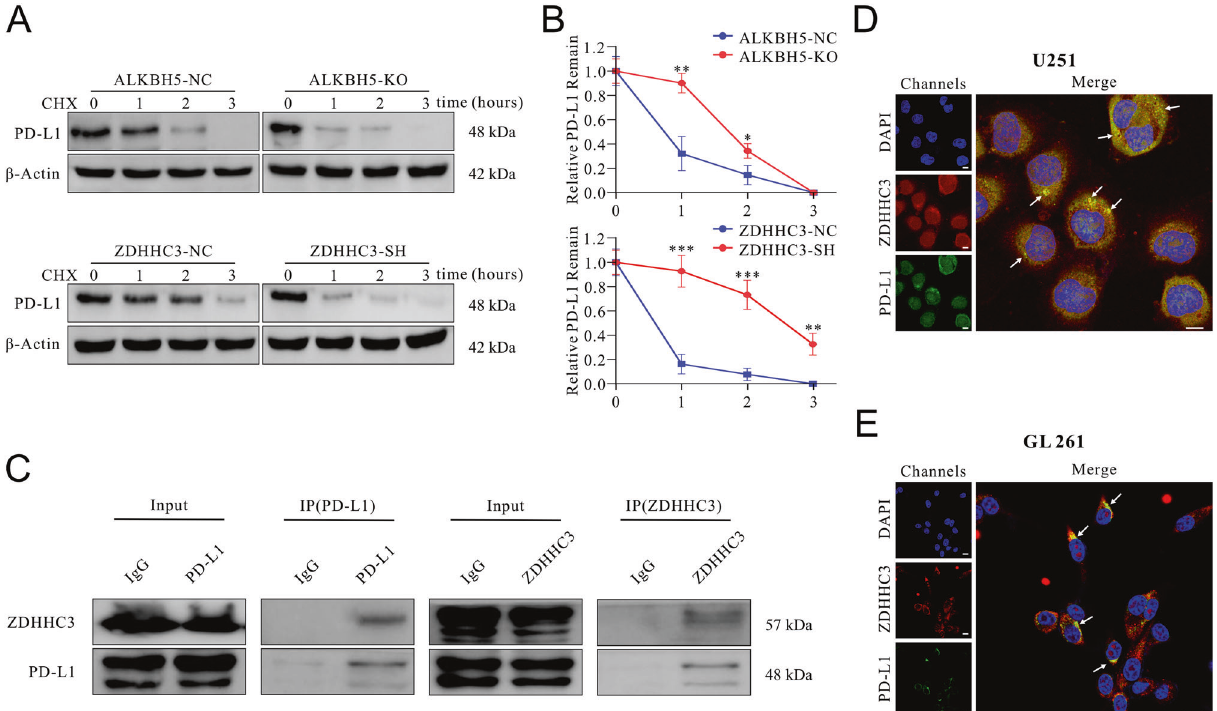
Fig. 5 Knocking-down ZDHHC3 suppressed PD-L1 expression by promoting the degradation of PD-L1. A U251 cells with ALKBH5 knockout or control (top panel) and U251 cells with ZDHHC3 knockdown or control (bottom panel) were incubated with cycloheximide (CHX), and protein was extracted at the indicated time points. After that, PD-L1 protein expression was analyzed by western blot. This experiment was repeated three times. B Quanti fi cation of the western blot results in A as mean ± SD. C A co-immunoprecipitation assay using ZDHHC3 or PD- L1 as bait protein showed the reciprocal physical interaction between ZDHHC3 and PD-L1 in U251 cells. Immuno fl uorescence of ZDHHC3 and PD-L1 in U251 ( D ) and GL261 ( E ) cells. Scale bar = 10 μ m. White arrows showed co-localization between ZDHHC3 and